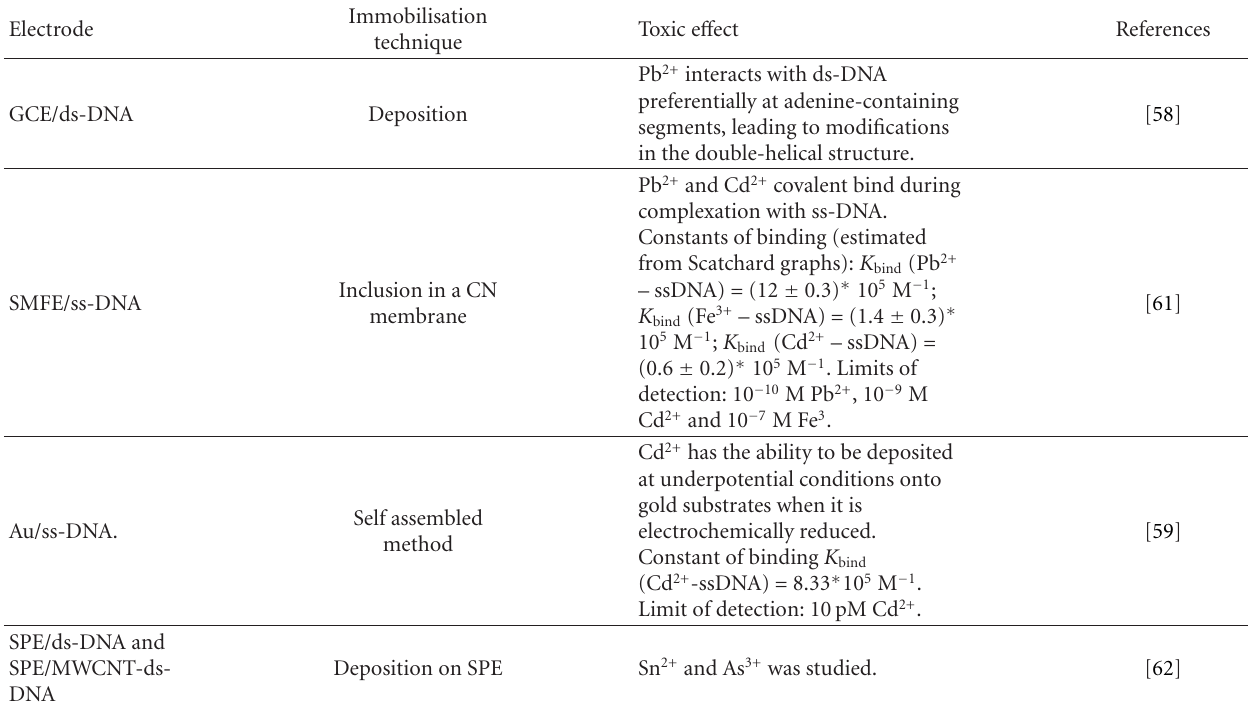
Table 5: Examples of DNA-based electrodes.